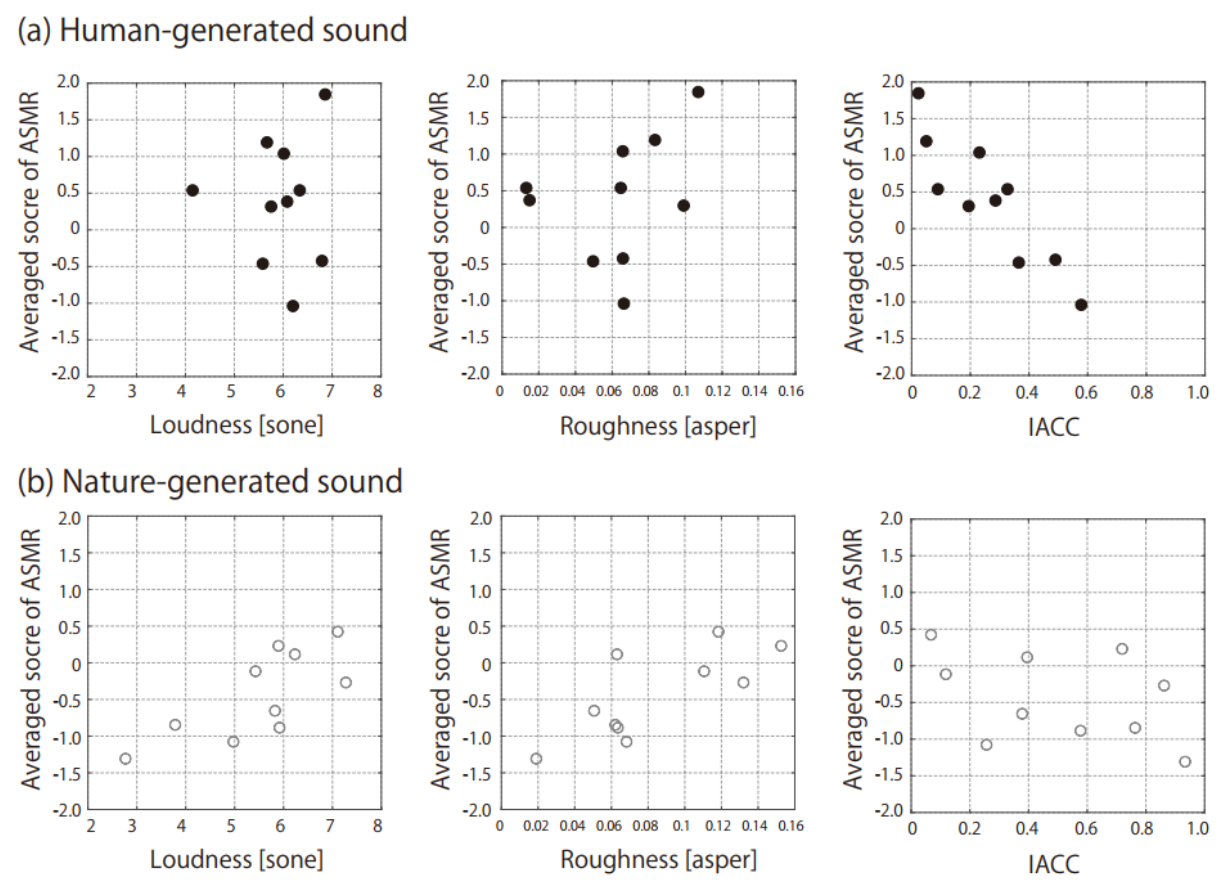
Figure 3. Relationships of the ASMR scores with loudness, roughness, and IACC for ( a ) human- generated sounds (black symbols) and ( b ) nature-generated sounds (gray symbols). Table 2. Correlation coefficients of the ASMR scores among Zwicker’s parameters,